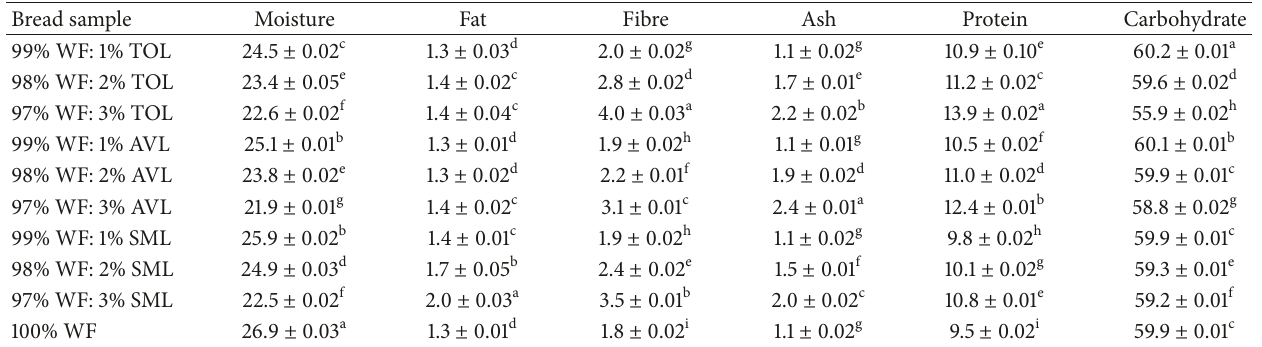
Table 2: Proximate composition (%) of wheat bread enriched with green leafy vegetable powders. Bread sample Moisture